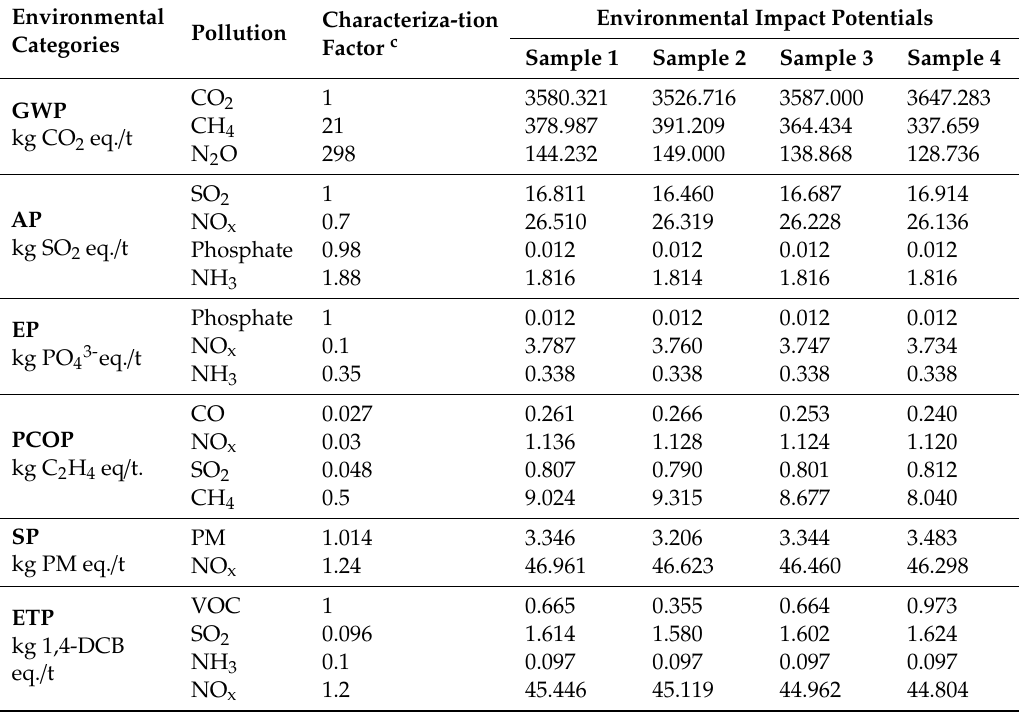
Table 2. Environmental impact potentials of di ff erent pollutants from 1 ton of Sample 1 to